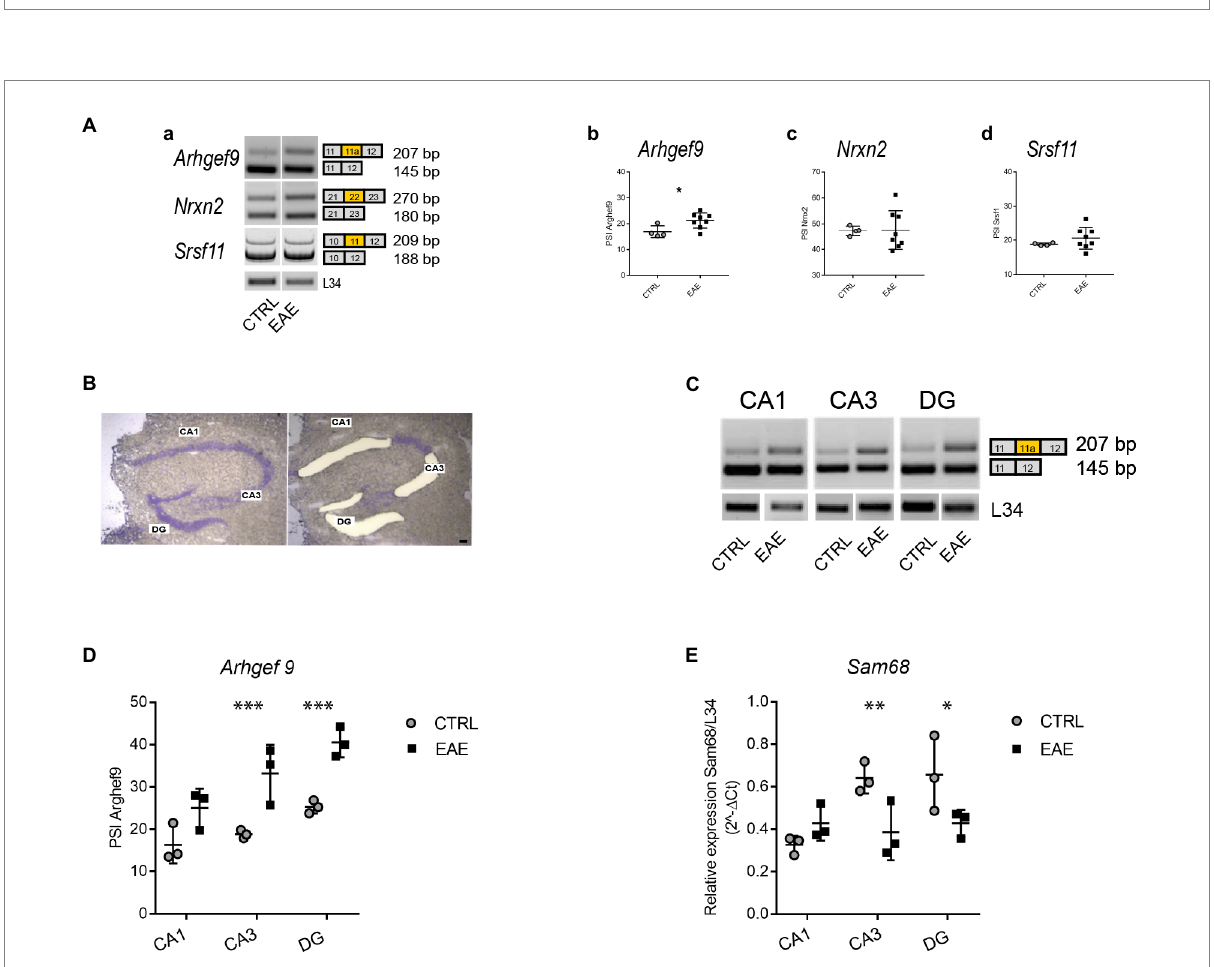
FIGURE 3 Experimental autoimmune encephalomyelitis (EAE) induces region-specific regulation of the Arhgef9 splicing pattern and Sam68 expression. (A) Analysis of the splicing pattern of synaptic genes that are target of STAR proteins, performed in the whole hippocampus of CTRL and EAE mice. (a) Representative agarose-gel images of the splicing pattern of Arhgef9 at exon 11a, Nrxn2 at alternatively spliced segment (AS) 4, and polyacrylamide-gel image of Srsf11 at exon 11 in CTRL and EAE mice; (b–d) : densitometric quantifications of the percentage of splicing inclusion (PSI) at alternatively spliced exon 11a of Arhgef9 (b) , at segment AS4 of Nrxn2 (c), at exon 11 of Srsf11 (d). While no significant modulation of PSI